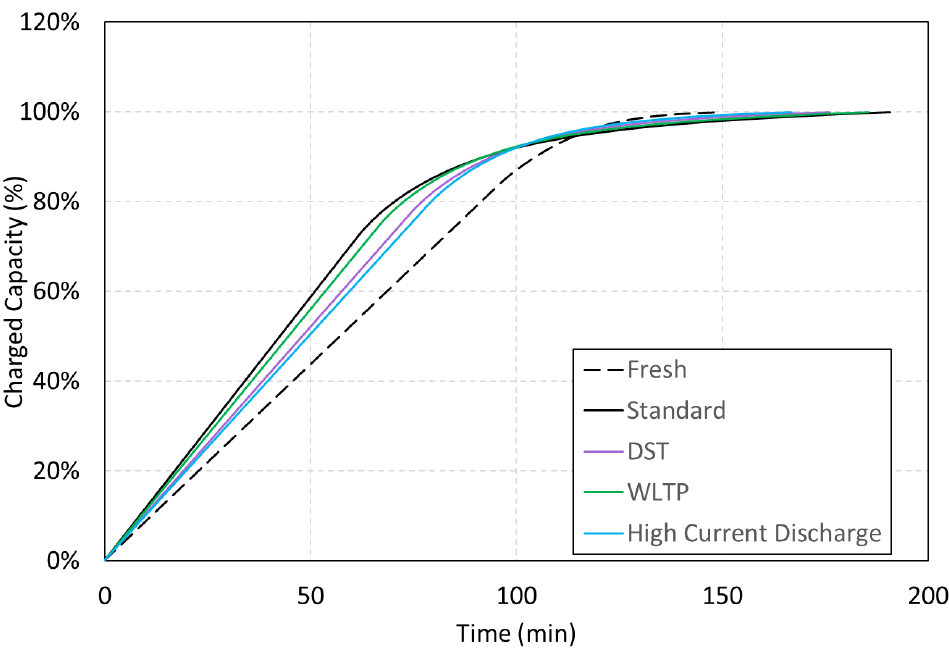
Figure 6. Evolution of charged capacity over time for a fresh cell and the different cycled cells, under a standard charging process.